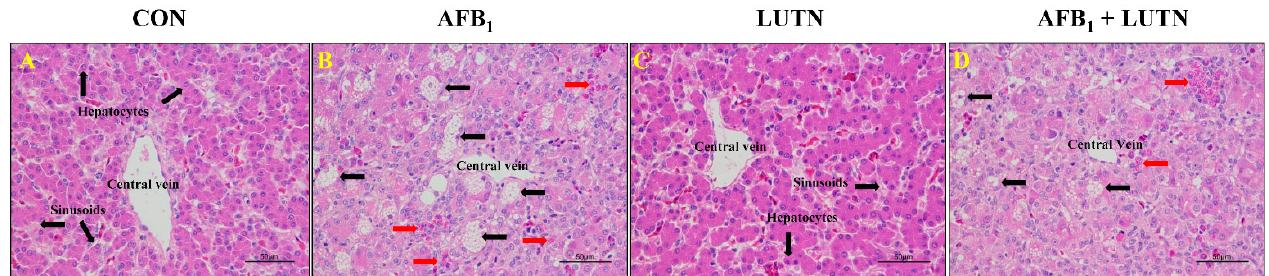
Figure 3. The histopathology of liver sections was stained with H&E staining. ( A , C ) Histological section of the liver from CON and LUTN group showed a normal histoarchitecture consisting of central vein surrounded by hepatocytes possessed sinusoids spaces. ( B ) The liver section from the AFB 1 group showed microvesicular (black arrow) appearance of the abundant fatty droplets with small and large area of blood infiltration (red arrow) showed a hepatotoxicity. ( D ) Liver tissue from the group of mice treated with LUTN and challenged with AFB 1 manifested recovered status of the liver from hepatotoxicity, as depicted small and rare patches of the lipids (black arrow) and the blood infiltration (red arrow) as compared to the AFB 1 alone challenged group.